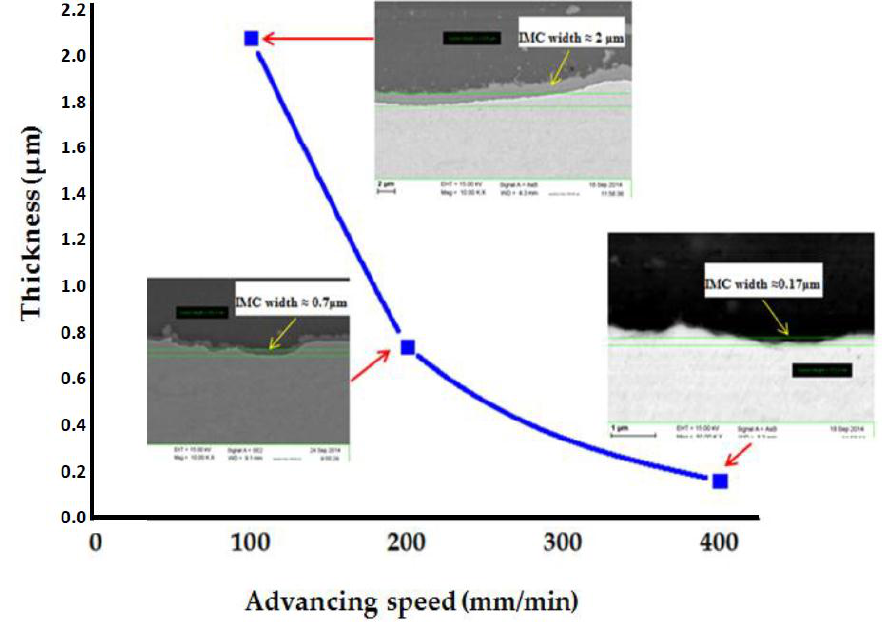
Figure 10. Thickness variation of the intermetallic compound layer IMC formed after different traverse